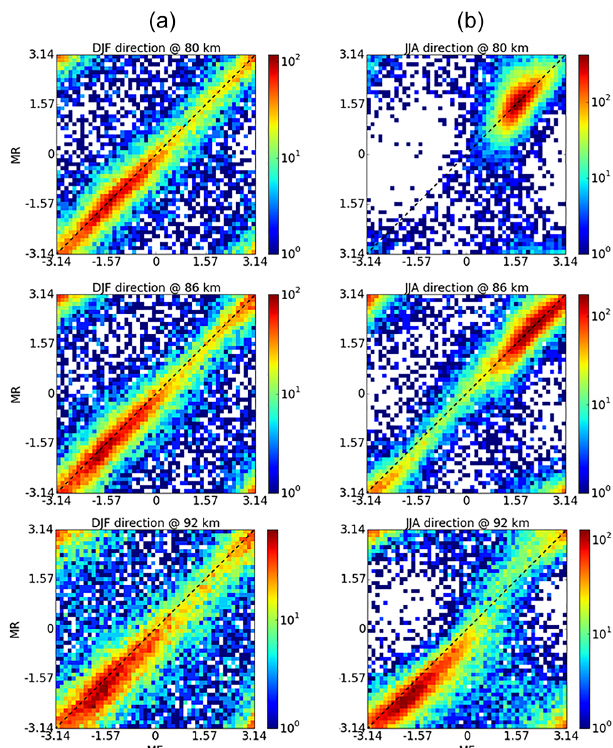
Figure 4. Scatter plots of the wind direction for DJF (a) and JJA (b) for 80, 86, and 92km. The black dashed line shows the line of equal-